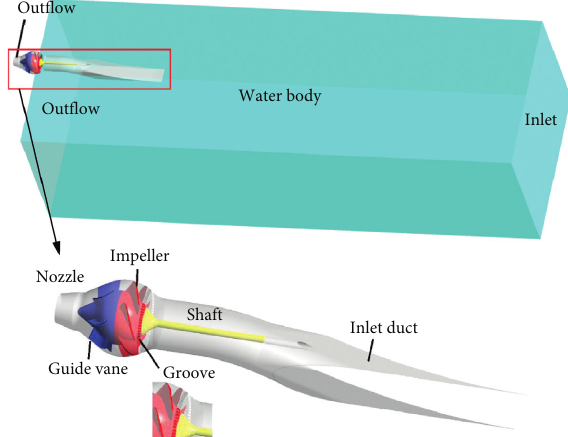
Figure 1: Computational domain.